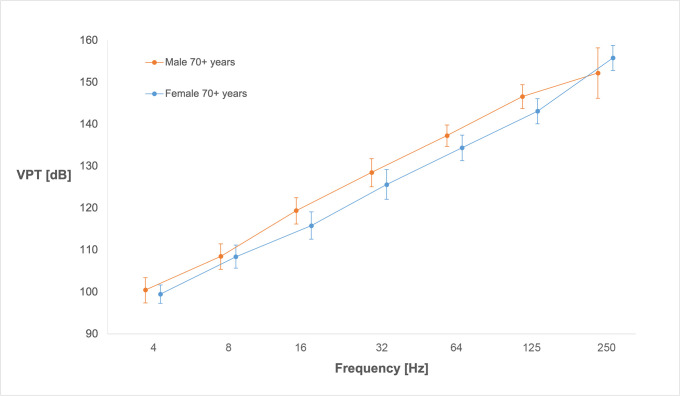
Vibration perception thresholds for fifth metatarsal head measured in males and females over 70 years.Y-axis shows mean vibration perception threshold (VPT) values in decibels (dB; relative 10−6 m/s2), and 95% confidence intervals, for the seven different frequencies (Hz) presented in the X axis. Subjects were males and females, all over 70 years (n = 29 in each group).